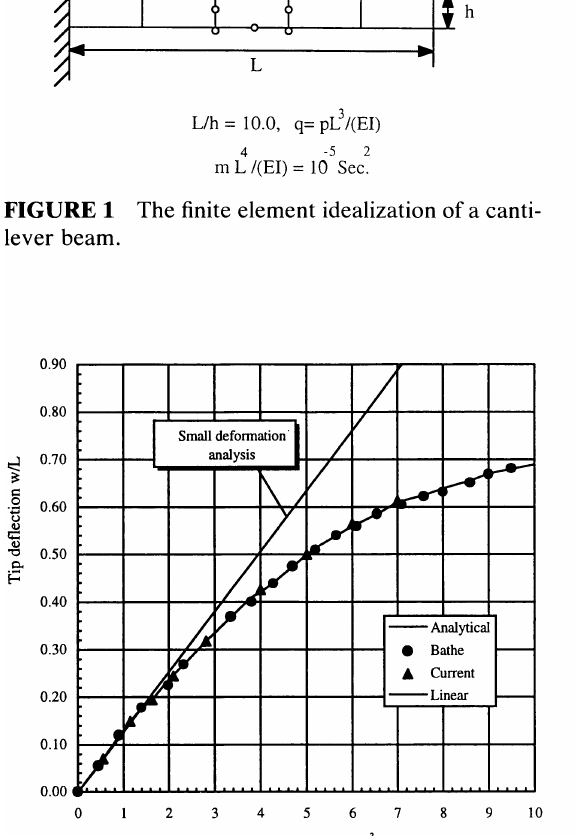
FIGURE 1 The finite element idealization of a canti lever beam.